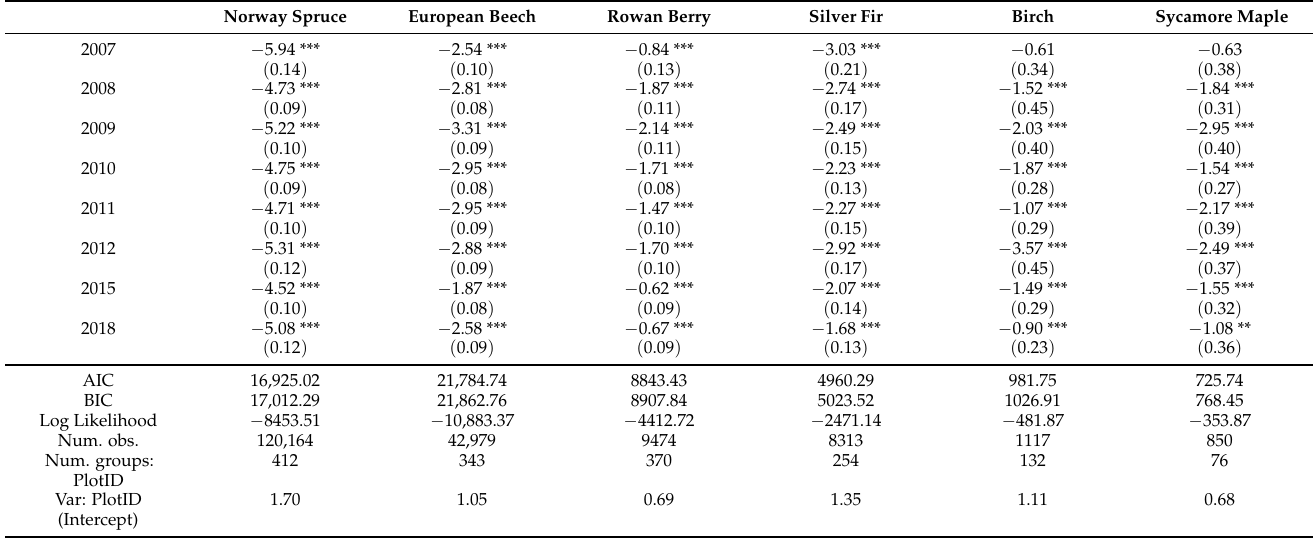
Table A1. Summary statistics of all logistic mixed effect models for the respective tree species. Next to each categorical time step, logarithmic coefficients and the standard error (in parentheses) can be found.